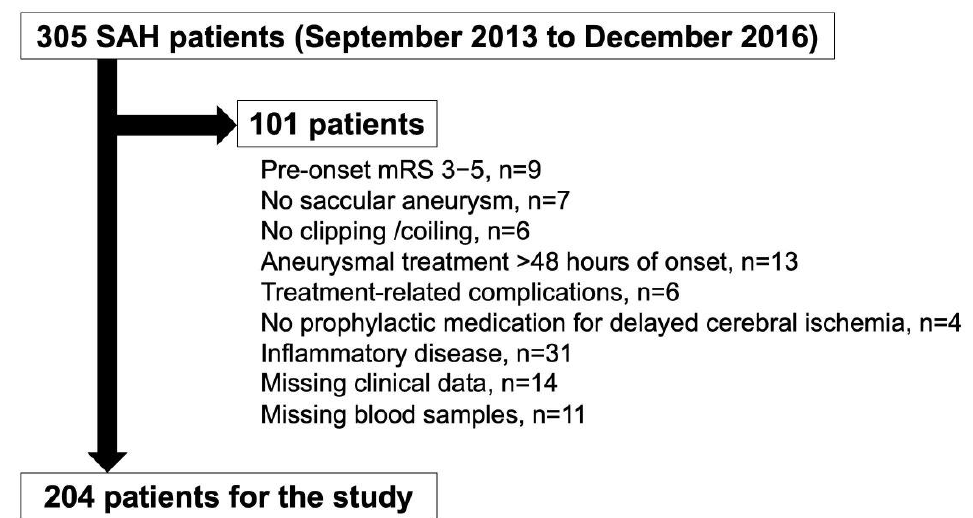
Figure 1. A flow chart showing the included and excluded patients in this study. mRS, modified Rankin scale; SAH, subarachnoid